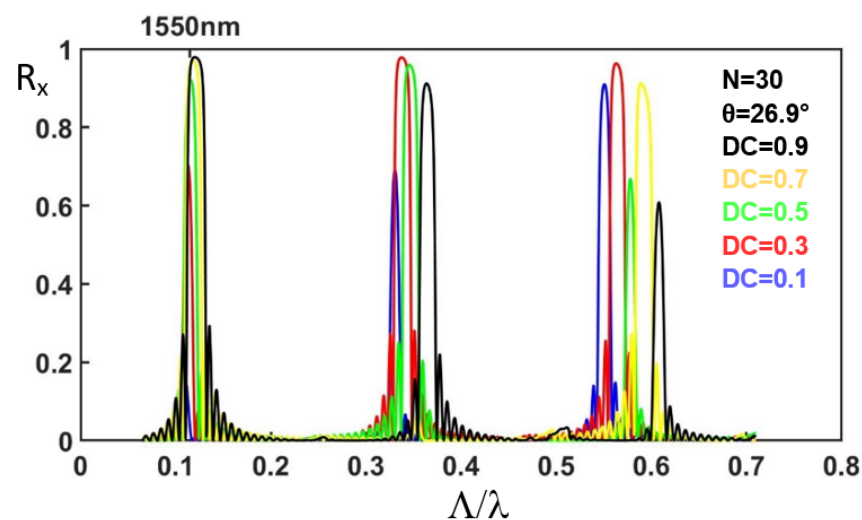
Figure 5. The reflection spectra of E X of the stack of birefringent waveplates with isotropic background for different duty cycles. The incident light is linearly polarized in the Y-direction. The period number is 30. The angle between the fast axis and the X-axis is 26.9 ◦ . Using the 4 × 4 matrix method, the band structure of the stack of birefringent wave- plates with isotropic background is calculated by solving the eigenvalue of the Bloch waves [24,33,34]. The precise band edge can be obtained. The duty cycle is 0.5. Figure 6a illustrates the band structure. The red and the blue curves present the dispersion of the slow and fast waves, respectively. The band edges of the first bandgap are at the normal- ized frequencies of 0.1127 and 0.1177, respectively. At these frequencies, the slow and fast waves meet the exchange Bragg condition [24], K s Λ + K f Λ = 2 m π , where K s and K f are the Bloch wave numbers for the slow and fast waves, respectively; m is an integer. The cou- pling (exchange) of the slow and fast waves or the so-called rotation of the polarization occurs at these band edges. The band edges of the second bandgap are at the normalized frequencies of 0.2210 and 0.2337 for the slow axis. The band edges of the second bandgap are at the normalized frequencies of 0.2232 and 0.2466 for the fast axis. At these frequen- cies, the polarization of the reflected light is identical to that of the incident light since K Λ is null where K is the Bloch wave number. The band edges of the third bandgap are at the normalized frequencies of 0.3430 and 0.3509, respectively. The band edges of the fifth bandgap are at the normalized frequencies of 0.5771 and 0.5781, respectively. The first, third, and fifth bandgaps correspond to the frequency ranges of the peaks in the reflection spectra shown in Figures 2a and 5. This indicates the fact that the reflection of the polari- zation rotator in the silicon waveguide originates from the photonic bandgap, and that the wavelength range of the reflection peaks can be estimated by calculating the band structure of the stack of birefringent waveplates with isotropic background.